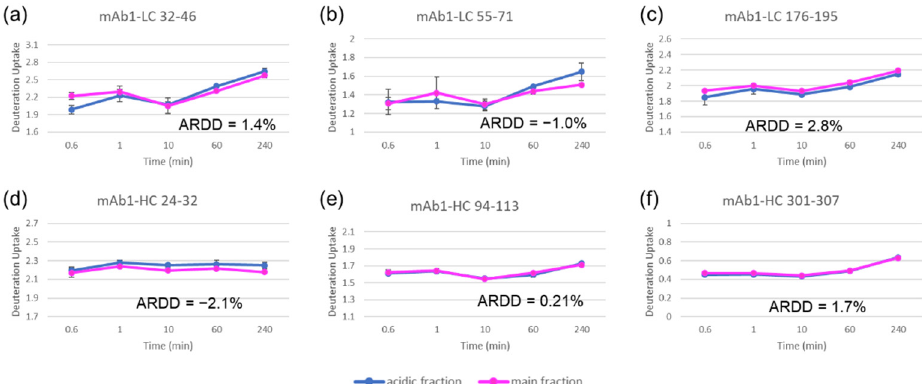
Figure 5. HDX-MS deuterium uptake time course plots for selected mAb1peptides of mAb1 Acidic